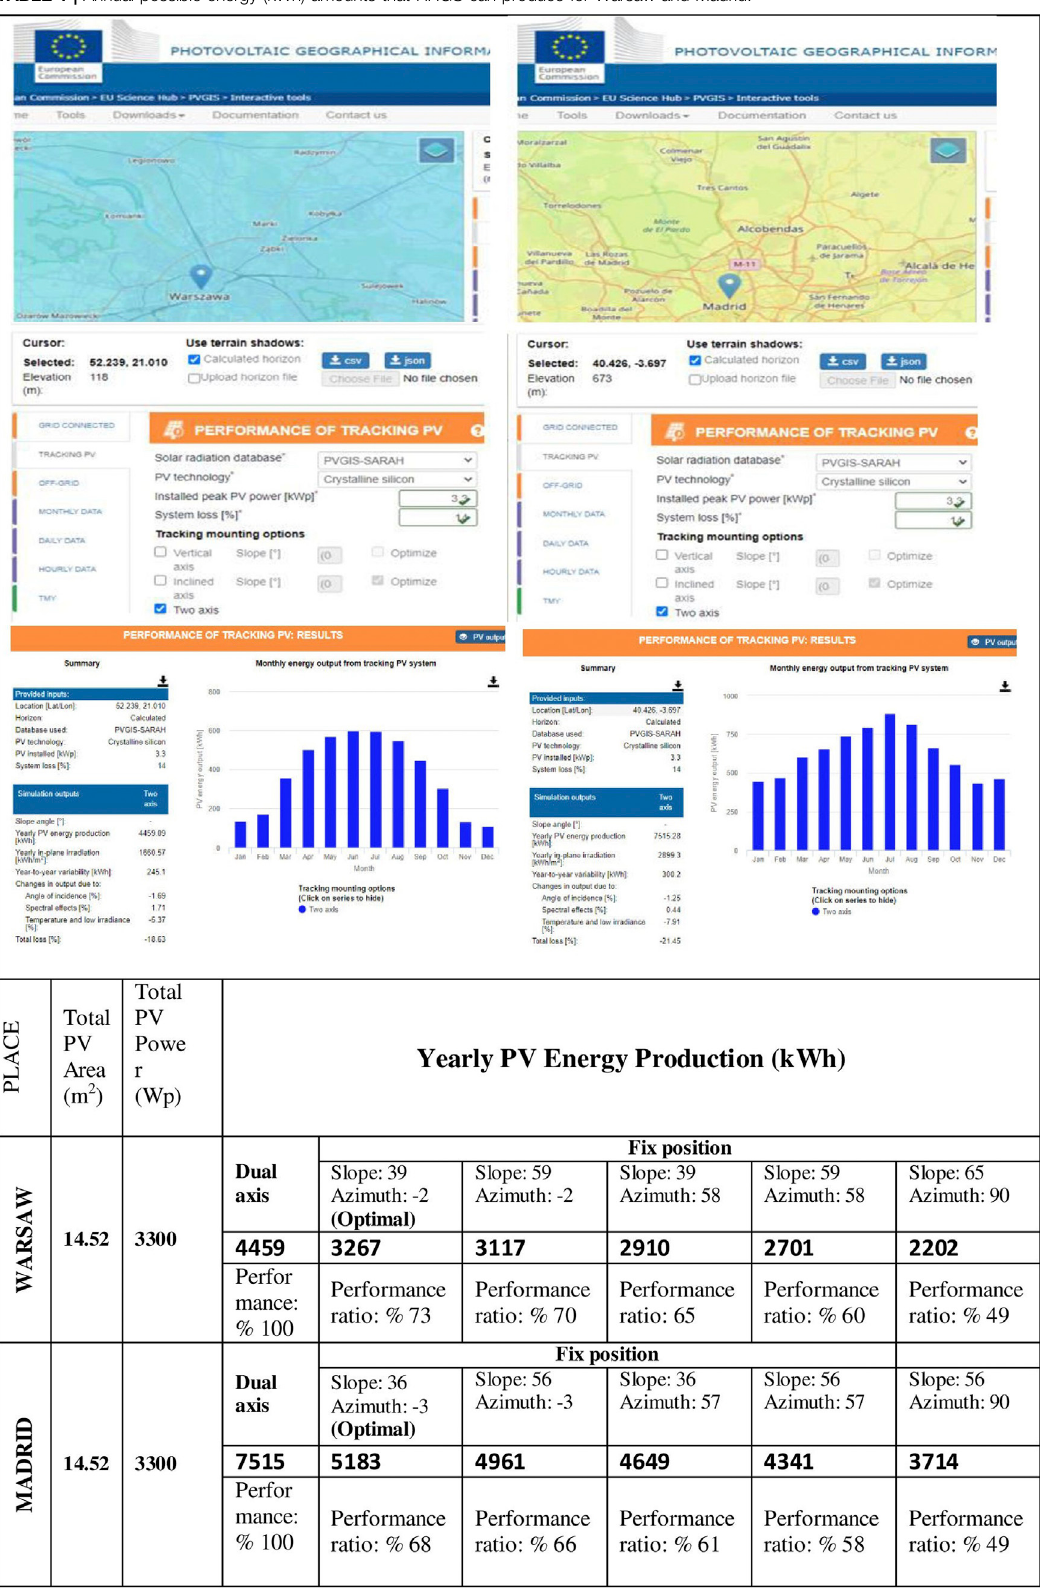
TABLE 1 | Annual possible energy (kWh) amounts that RRGS can produce for Warsaw and Madrid.